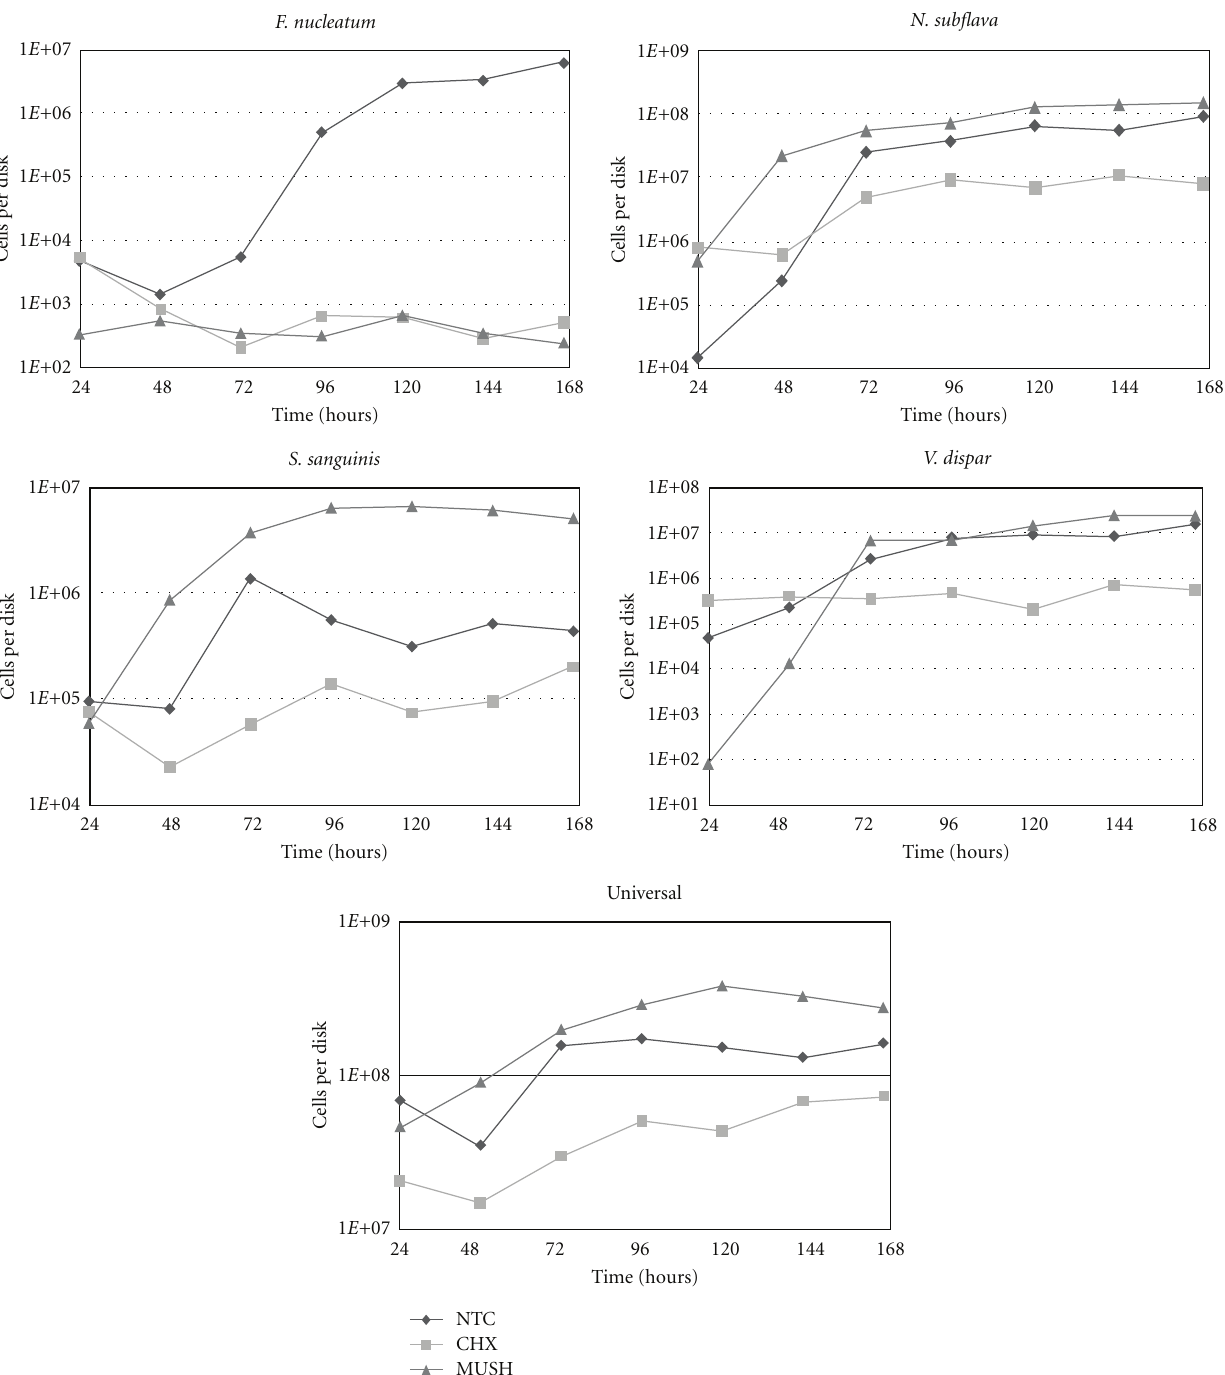
Figure 2: F. nucleatum , N. subflava , S. sanguinis , V. dispar , and total bacterial cell numbers which displayed significant di ff erences between the di ff erent